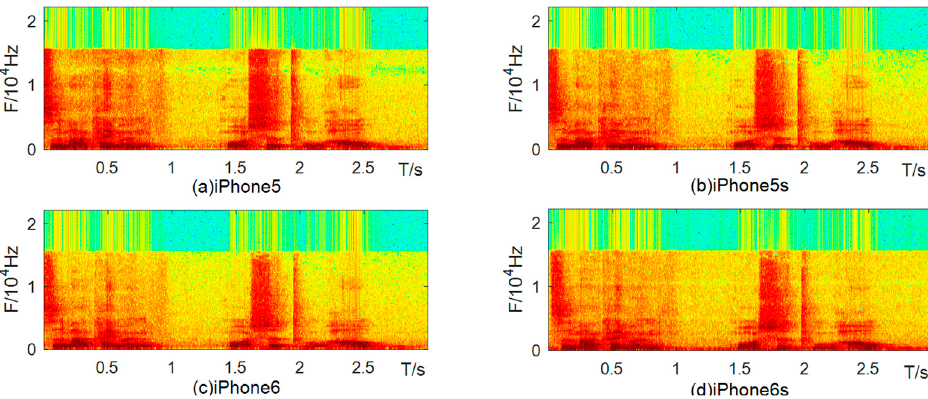
Figure 1. Spectrogram of speech files recorded by different brands of cell-phones.